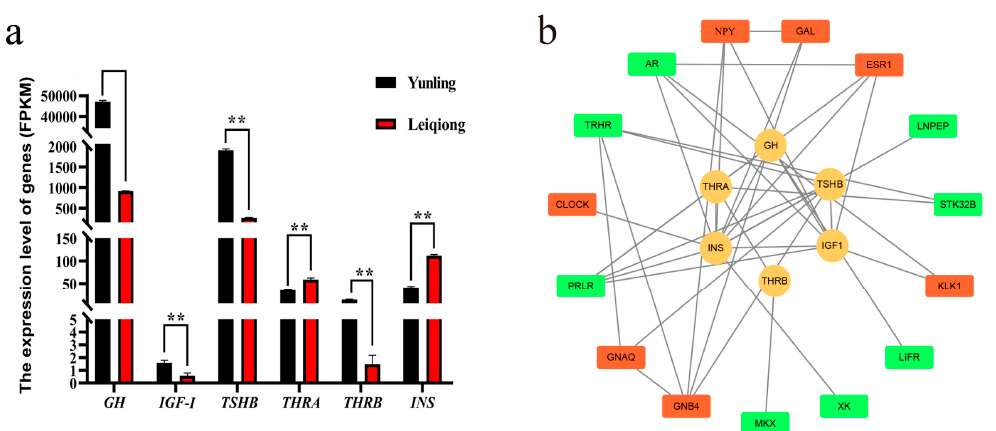
Figure 7. Expression levels of hormone-regulating genes and protein–protein interaction (PPI) network of DEGs with them. ( a ) Expression analysis of hormone-regulating genes, measured by FPKM (mean ± SEM, ** p < 0.05); All genes have significant expression differences between the two groups, of which GH , IGF-I , TSHB, and THRB were higher in Yunling group and THRA and INS were higher in Leiqiong group; FPKM, fragments per kilobase per million; ( b ) PPI network of DEGs with these hormone-regulating genes (the nodes in green are DEGs that did not appear in significantly different KEGG pathways ( p < 0.05); the nodes in red are DEGs that also appeared in significantly different KEGG pathways ( p < 0.05); the nodes in yellow are six hormones-regulating genes in this research).